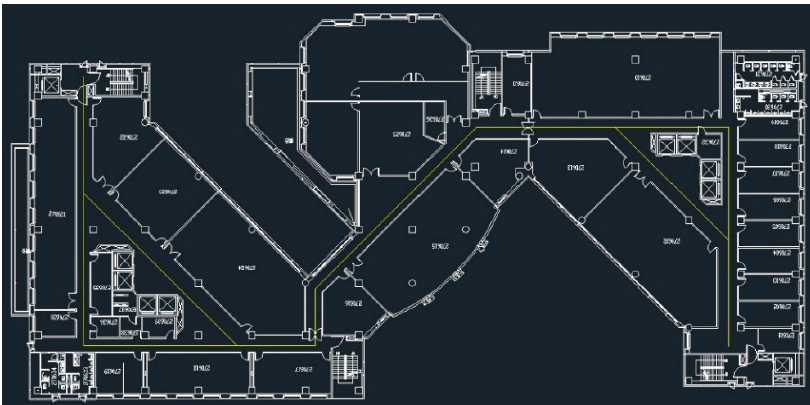
Figure 7. Floor plan of the sixth floor of the general building.